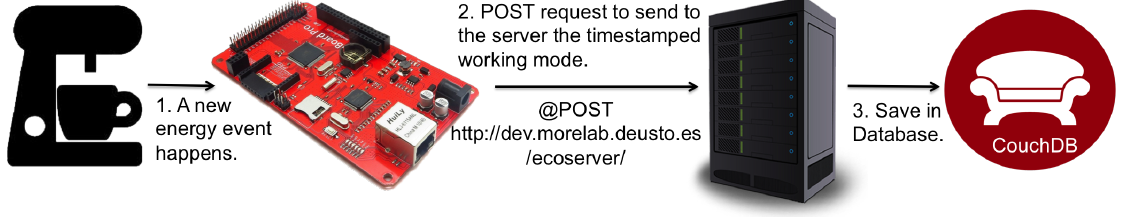
Figure 1. The energy consumption data flow from the Ethernet-based Arduino microcontroller board to the remote server where the data were stored for later processing and analysis